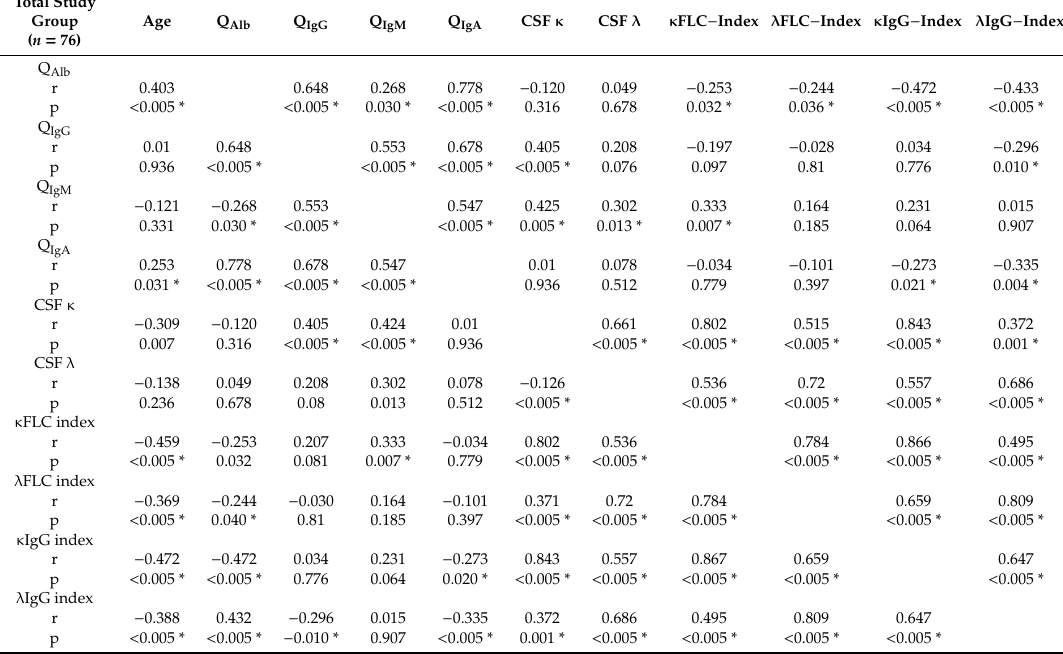
Table 3. Spearman’s correlations between tested variables in the total study group.